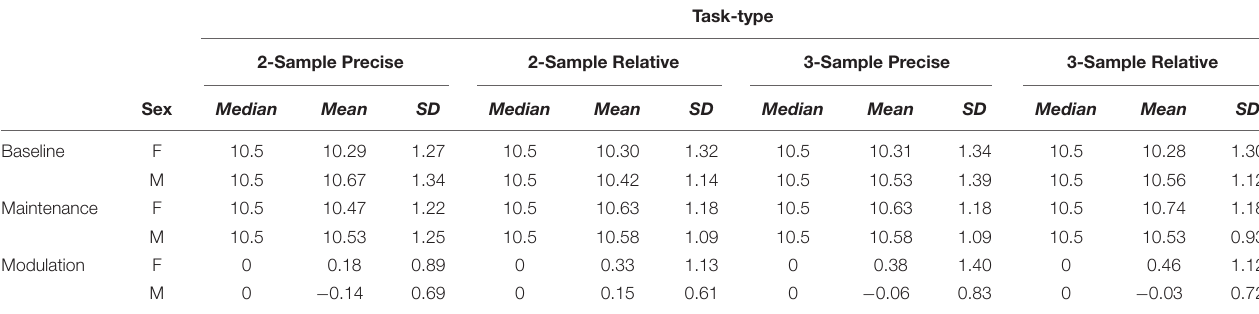
FIGURE 4 | Distributions of PAF Modulation by Sex. Comparison between Male and Female distributions by shift function. (A) Stripchart of PAF Modulation distributions (mean Modulation across Task-types) for Males and Females. (B) Stripchart shown in (A) with quantiles and differences between distribution quantiles characterized (see Figure 2 caption for detailed explanation). (C) Shift function between Male and Female distributions. The Female distribution exhibits a positive shift at each quantile compared with the Male distribution. The difference is greatest in higher quantiles. Two-sample, two-sided Kolmogorov–Smirnov test: D = 0.29, p < 0.05. Females exhibit significantly more positive PAF Modulation than Males. TABLE 2 | Measures of central tendency—medians, means, and standard deviations (SD)—in peak alpha frequency (PAF) by group: Females (F) and Males (M).